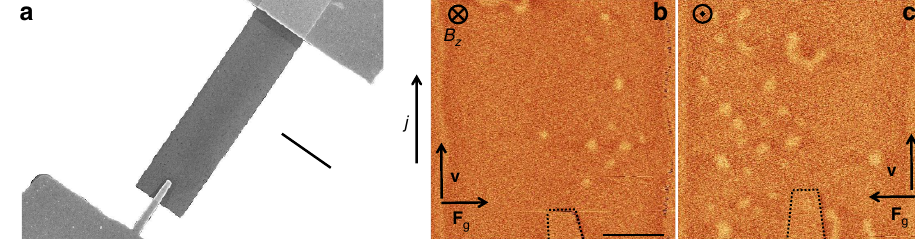
Figure 3 | The gyrotropic force. ( a ) SEM micrograph of the sample geometry used for skyrmion generation demonstration. The 3 m m ferromagnetic stripe is connected to Ti \ Au pads with an injection finger 300nm wide. Scale bar, 3 m m. ( b ) Resulting state after application of a series of 8ns long pulses in an external field of B z ’ (cid:2) 6mTwhere j ¼ 3 (cid:4) 10 11 Am (cid:2) 2 . Scale bar, 1 m m. ( c ) The same experiment with B z ’ þ 6mTshows skyrmion accumulation on the left side of the device. The dashed line indicates position of the Ti/Au finger. SEM, scanning electron